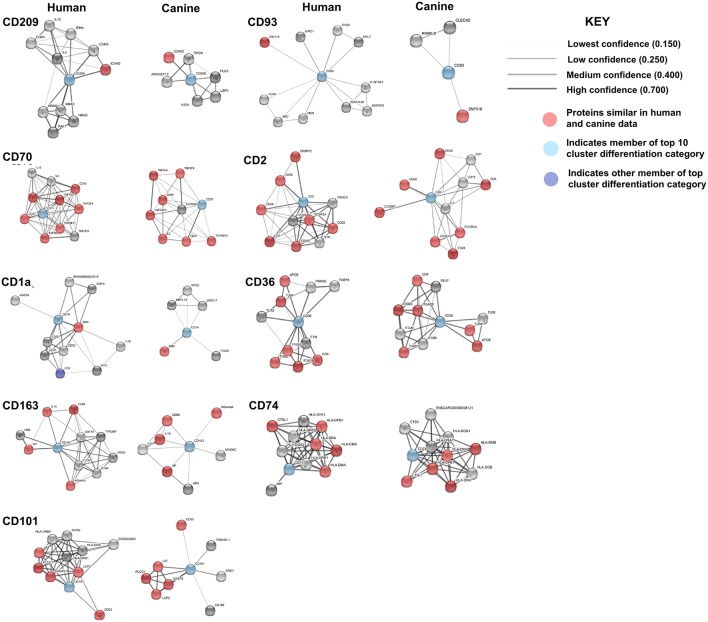
Comparison of the suggested protein associations of the top 10 downregulated genes. Data was collected using the STRING database (functional protein association network version-10-5) at medium confidence (0.400). Increasing confidence is demonstrated by increased thickness and darkness of edges (intersecting lines). Red notes indicate proteins involved in similar associations in both humans and canines. Light Blue nodes indicate proteins that are members of the top 10 CD category. Dark blue nodes indicate proteins that are members (other than the CD gene being evaluated) of the CD gene category.